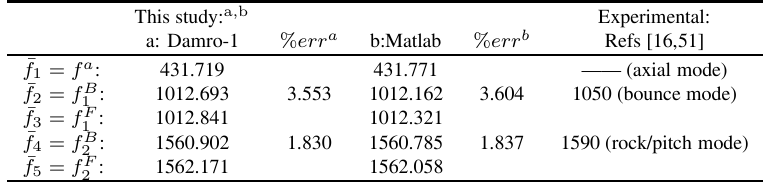
Table 9 Natural frequencies ¯ f k (Hz) of spindle-ball bearings assembly for Ω s = 1000 rpm,